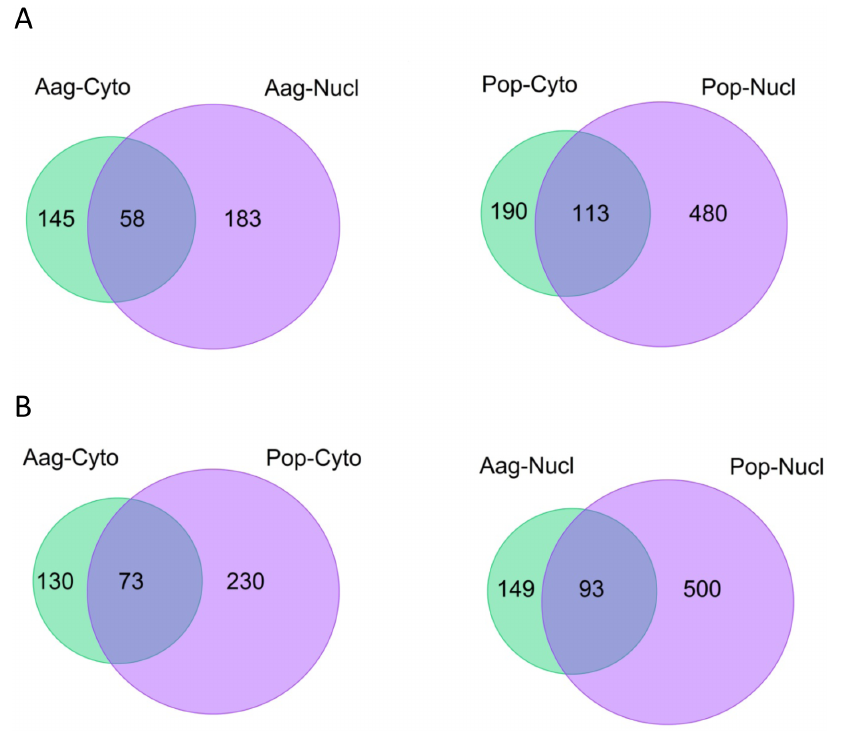
Figure 10. piRNA expression comparison in the nucleus and the cytoplasm of Aag2 and Pop cells. (A) Comparison of cytoplasmic versus nuclear fractions in Aag2 and Pop cells. (B) Comparison of Aag2 versus Pop cells in the cytoplasmic and nuclear fractions.